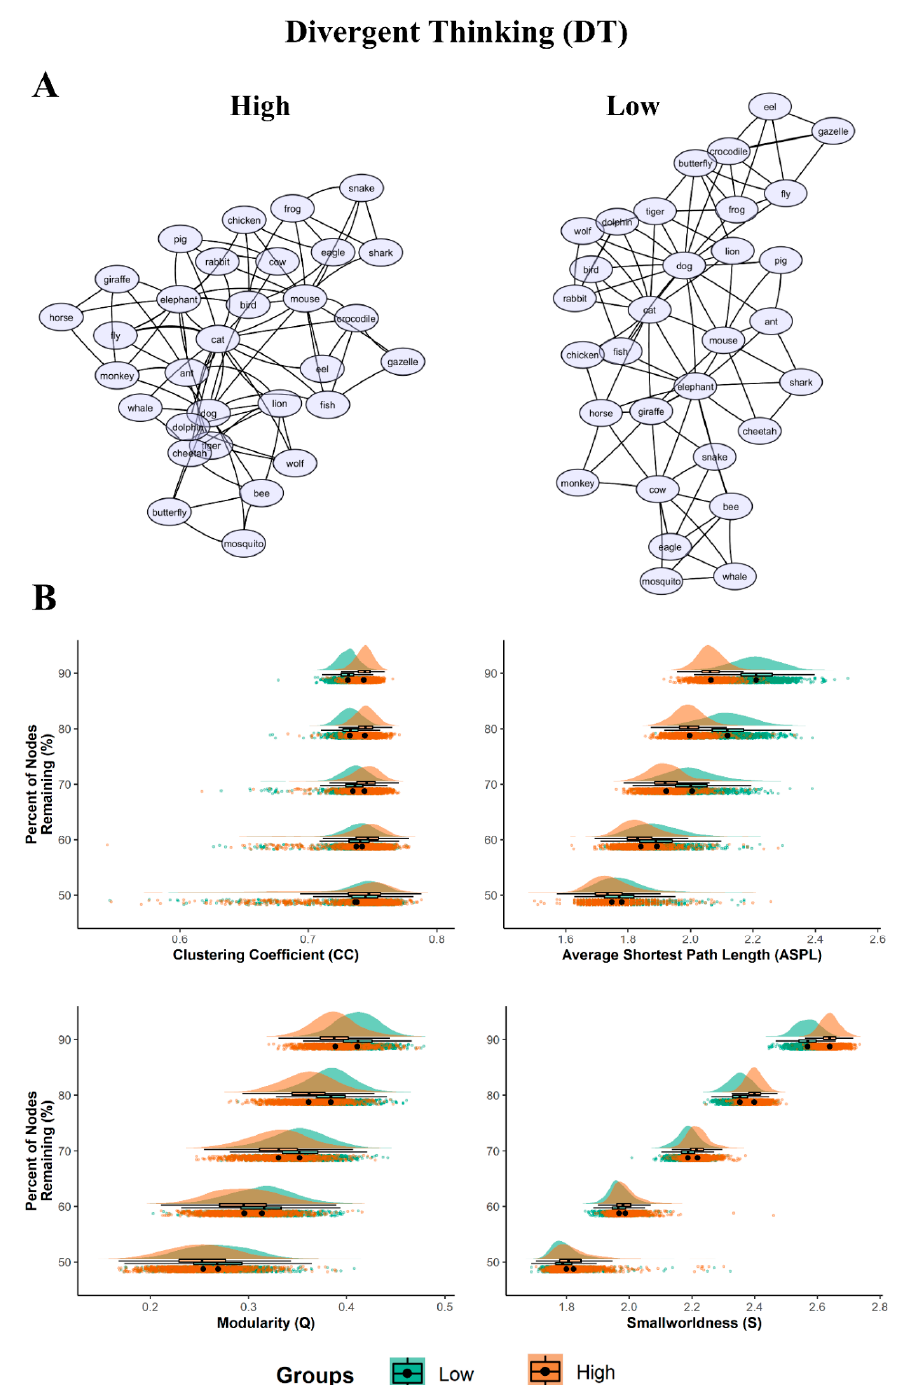
Figure 1. Semantic networks and bootstrapped results for DT. ( A ) 2D graph visualizations of the DT groups (high and low). The graphs are unweighted and undirected, with nodes (word responses) represented as circles, and the links between them (edges) represented as symmetrical similarities between two nodes; ( B ) Plots of the bootstrapped partial network measures (1000 samples per nodes remaining percentage). The density plots are above the scatterplots (individual dots depict a single sample), with a black dot representing the mean. The y-axis denotes the percentage of nodes remaining, with the legend of the DT groups (low and high) below the plots. All p < 0.001.